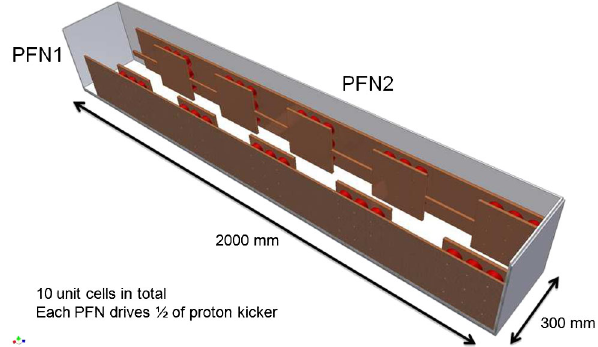
FIG. 39. A complete PFN assembly for a kicker for the proton ring; the box houses two